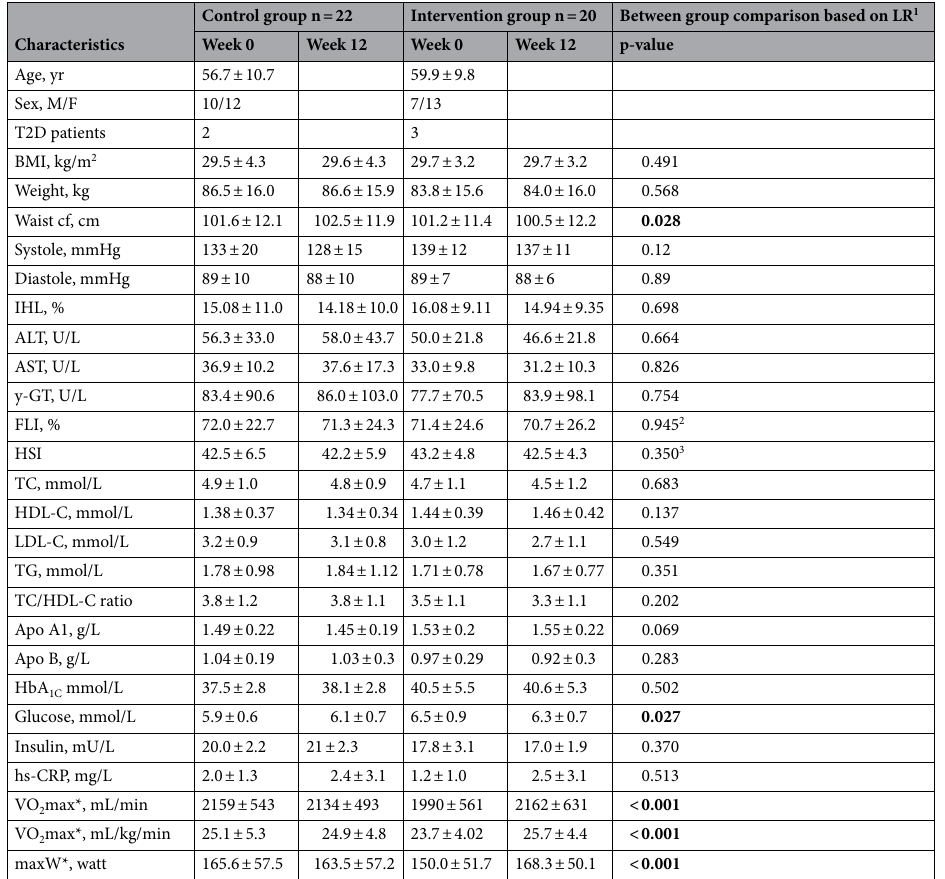
Table 1. Clinical parameters of the study. yr year, M male, F female, T2D type 2 diabetes, BMI body mass index, cf circumference, ALT alanine transferase, AST asparagine transferase, y-GT